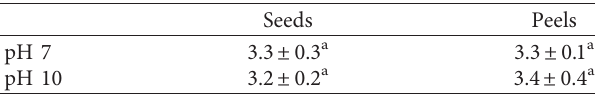
Table 3: Average bulk mass transfer coefficients ( × 10 − 5 ) for the onset of the adsorption (s − 1 × 10 − 5 ) ∗ . Seeds Values ± standard deviation. ∗ Different superscript letters in the same column indicate significant differences ( p ≤